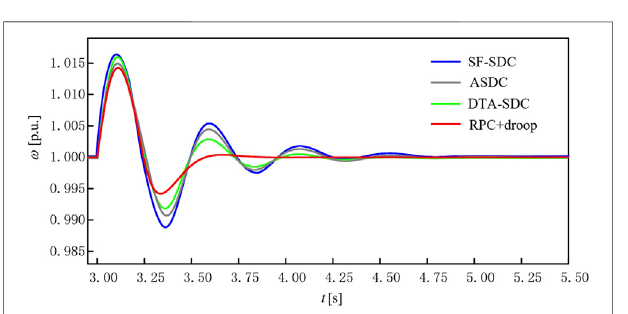
FIGURE 14 | Rate of change of rotor speed under the state-of-the-art suppression methods.